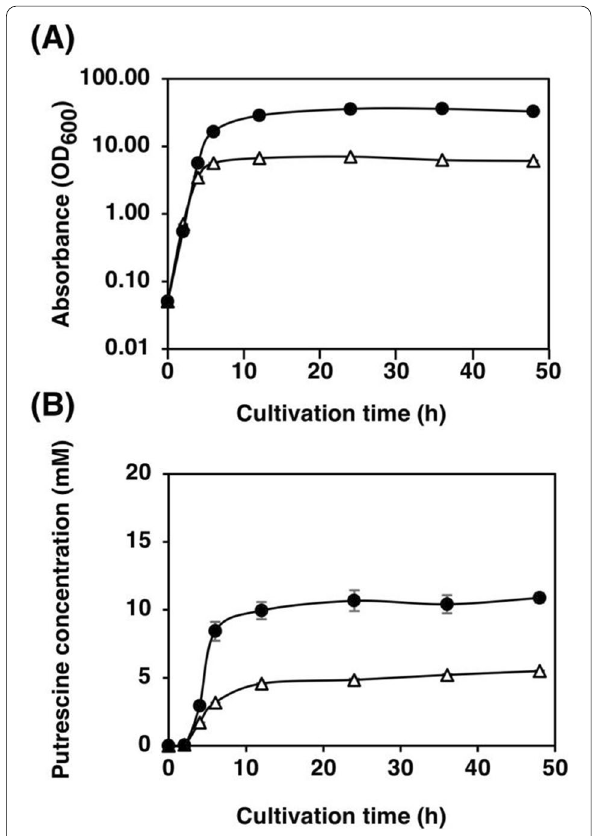
Fig. 7 Effects of culture media on putrescine production by strain KT152. A Bacterial cell growth and B putrescine concentration in the supernatant of the strain KT152, whose putrescine utilization pathway (Δ puuAP Δ patA ) was disrupted. Open triangles represent the strain KT152 grown in the LB medium supplemented with 100 μg/mL of ampicillin; closed circles represent the strain KT152 grown in terrific broth supplemented with 100 μg/mL of ampicillin. When the OD 600 reached 0.4, 0.03 mM IPTG was added. Data shown are averages standard deviations, and culture experiments were ± performed in